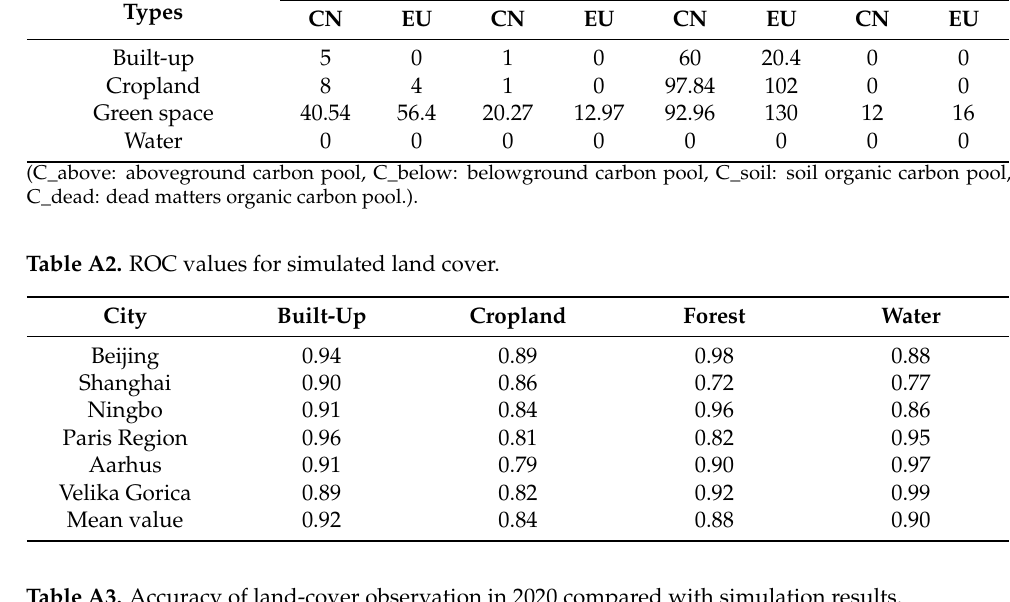
Table A3. Accuracy of land-cover observation in 2020 compared with simulation